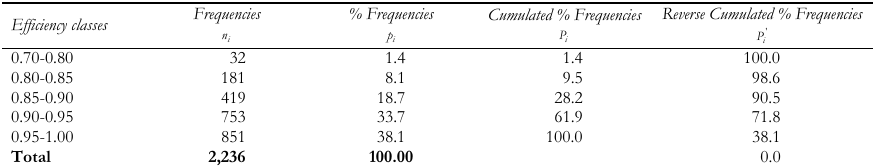
Frequency distribution of the overall technical efficiency